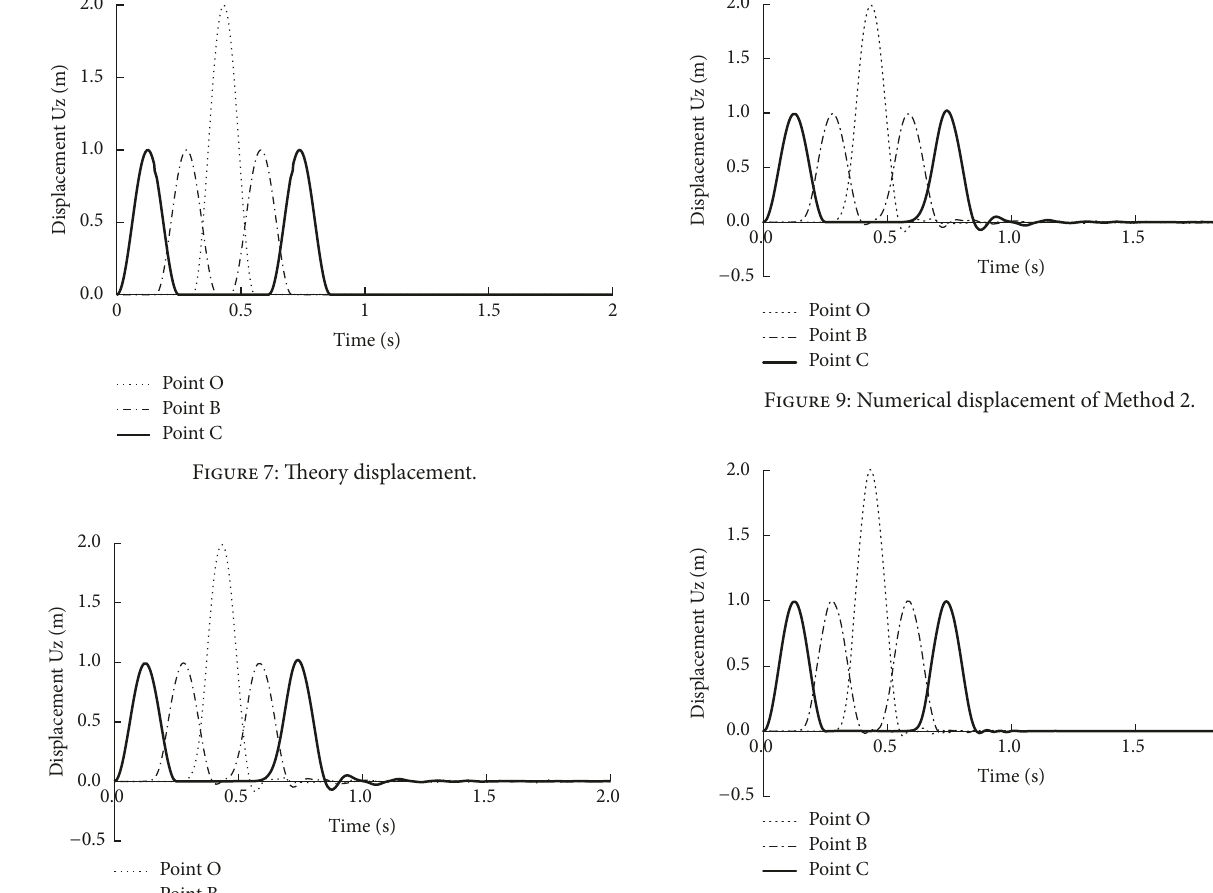
Figure 10: Numerical displacement of Method